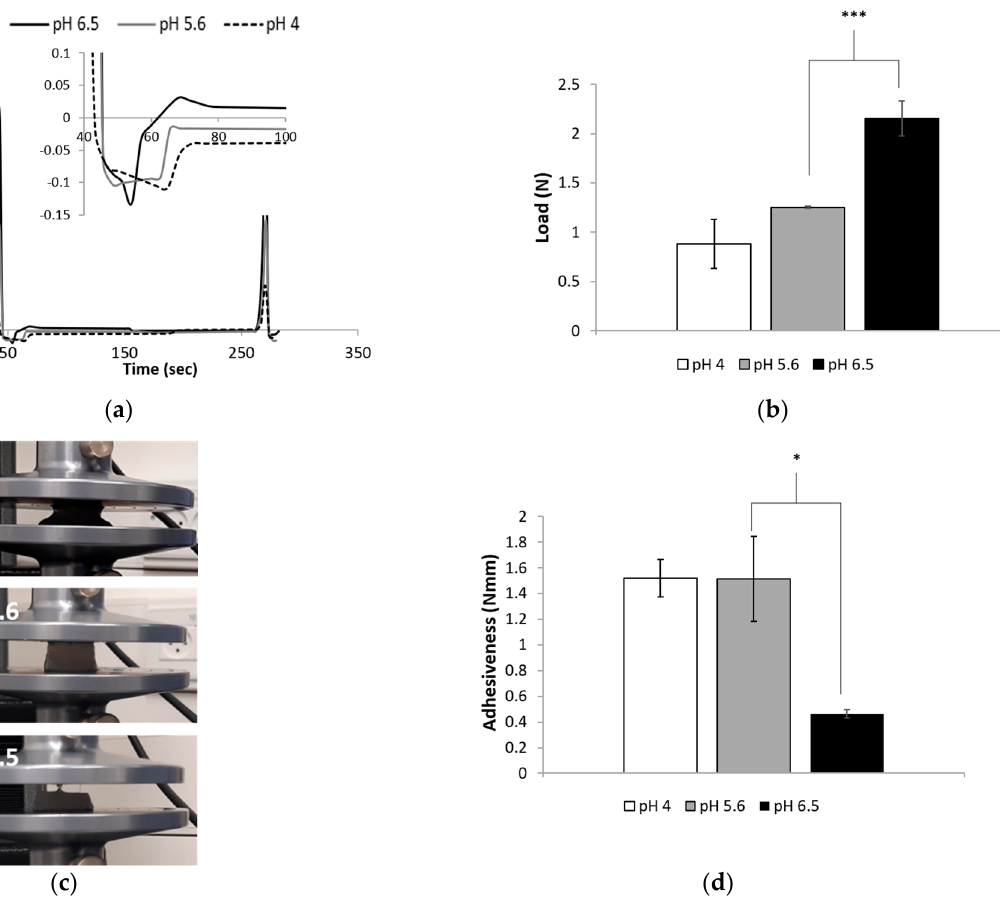
Figure 8. Texture profile analysis experiment. ( a ) Force–deformation curves, ( b ) hardness (ANOVA p < 0.005), ( c ) qualitative observation of the adhesiveness, and ( d ) adhesiveness (ANOVA, p < 0.05) of hydrogels cross-linked for 160 h and prepared at three different pH values. The bars represent the standard error of the mean, n = 5. (*) refers to a statistically significant difference of p < 0.05, and (***) refers to a statistically significant difference of p < 0.005.